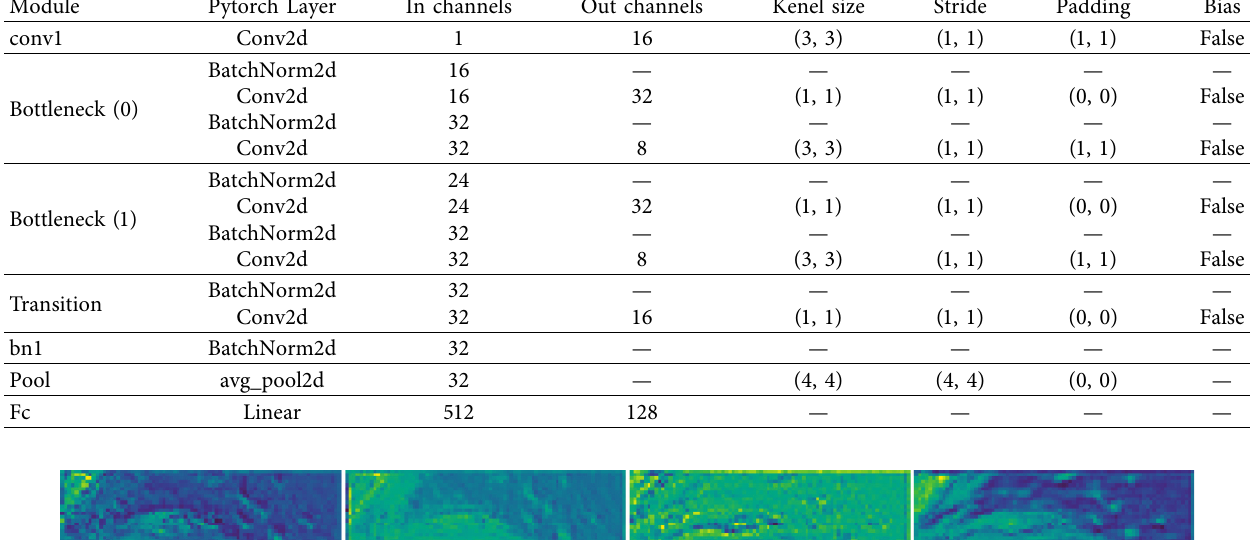
Table 1: The network parameters for spatial feature extraction.